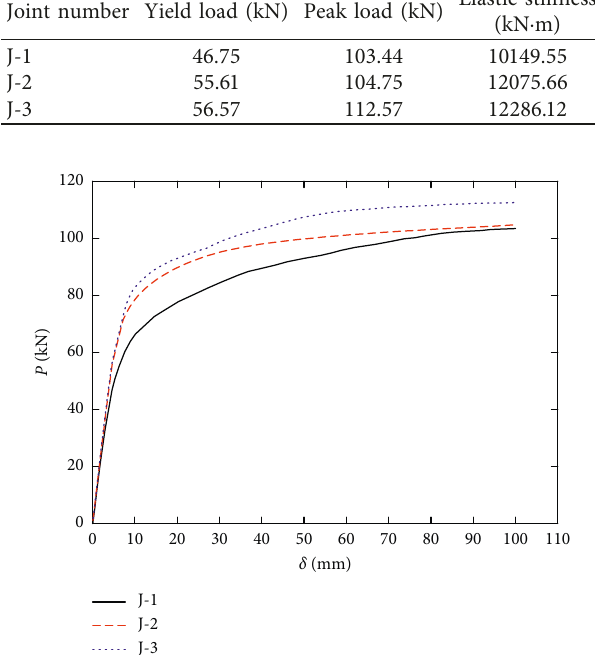
Figure 9: Comparison of the monotonic curves.